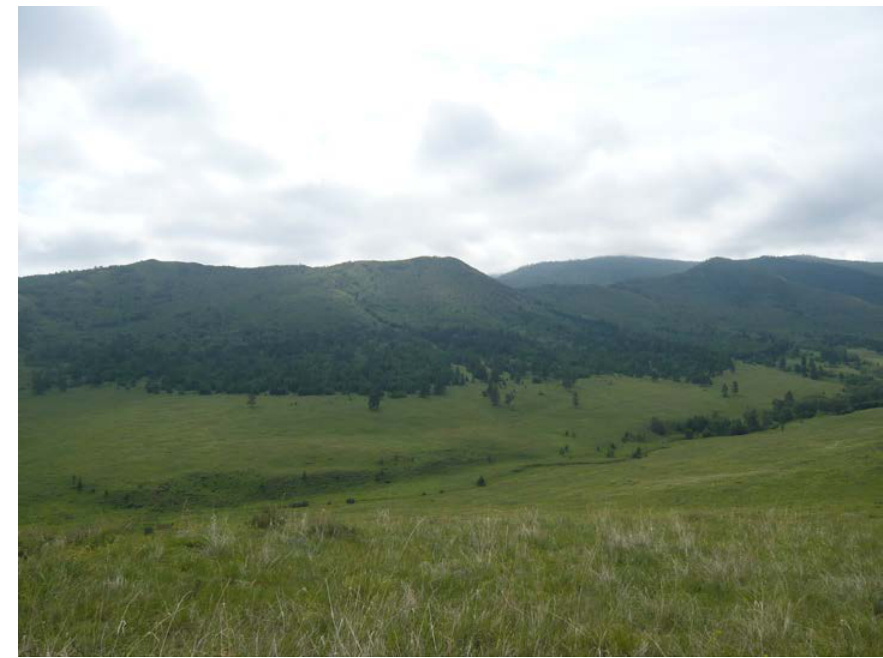
Figure A3. View of the larch stand LI.